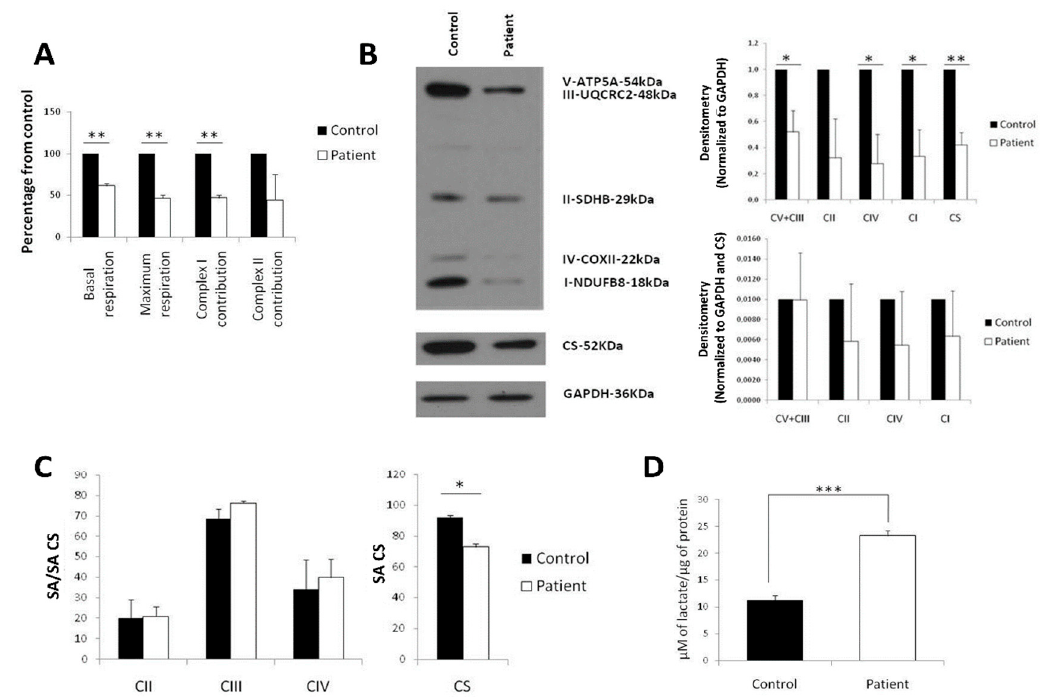
Figure 1. Decreased mitochondrial mass and respiration in Leigh syndrome (LS) fibroblasts. ( A ) Oxygen consumption measured in Oroboros Oxygraph-2k. All data are displayed as a percentage of control. ( B ) Western blot assay against mitoprofile, citrate synthase (CS) and GAPDH (left). Quantification of the Western blot, normalized with GAPDH as a marker of the total protein (right, top panel) or GAPDH and citrate synthase (CS) as a marker of mitochondrial mass (right, bottom panel). All data are displayed as a percentage of control. ( C ) Spectrophotometric measurements of the activity of electron transfer chain (ETC) complexes (left) and citrate synthase (CS) (right); SA: specific activity. ( D ) Extracellular lactate production normalized by total protein. (* p -value < 0.05; ** p -value < 0.01; *** p -value < 0.001)